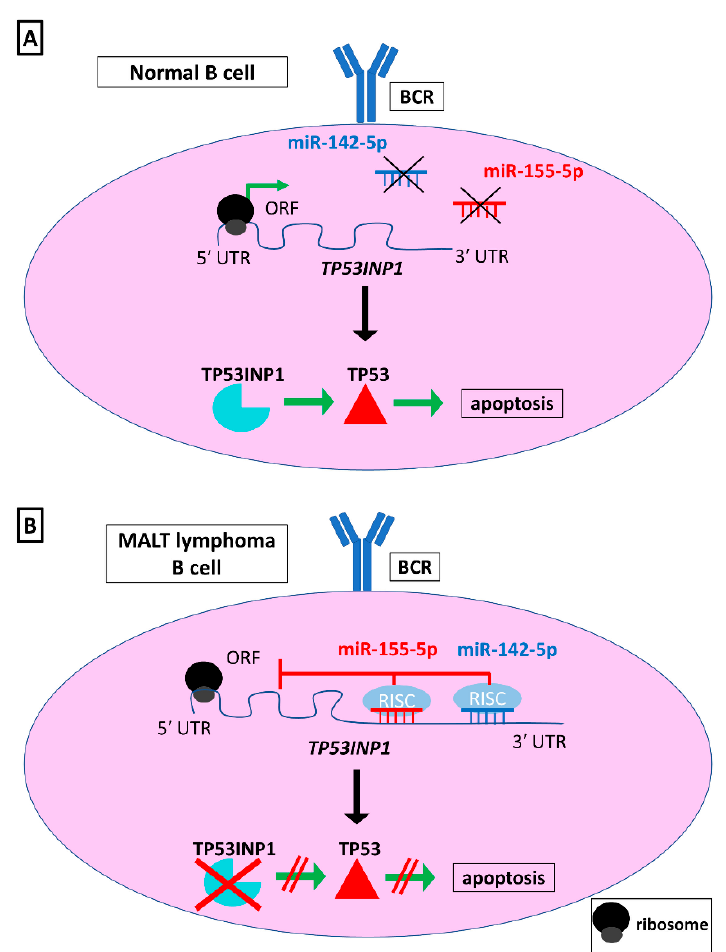
Figure 4. One of the potential effects of miR-155-5p and miR-142-5p in a normal B cell ( A ) and a mucosa-associated lymphoid tissue (MALT) lymphoma B cell ( B ). In physiological state, their expression levels are low and their target gene, TP53INP1 , is expressed, leading to activation of TP53 and, subsequently, to apoptosis. On the contrary, in a MALT lymphoma B cell, the expression levels of miR-155-5p and miR-142-5p are increased, leading to decreased expression of their target. This results in apoptosis inhibition, one of the hallmarks of a malignant cell. Black arrows indicate transition to the next step; red “reverse tau” symbols ( ⊥ ) indicate inhibition, whereas green arrows indicate promotion of a cellular process. Abbreviations: BCR, B-cell receptor; RISC, RNA-induced silencing